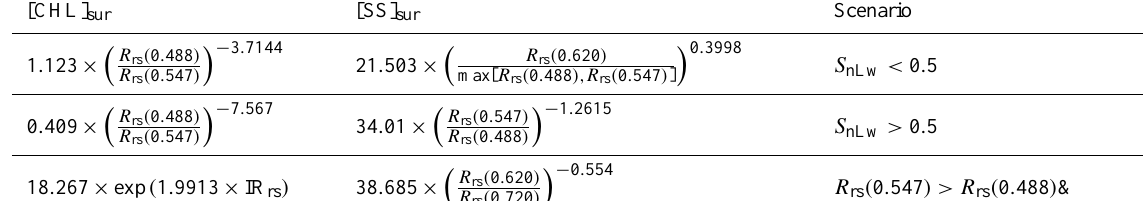
Table 3. Empirical relationships between the in situ R rs and in situ surface concentration ([Chl] sur and [SS] sur ) in a variety of waters for three different scenarios. Note that S.No. 3 will have another expression [Chl] sur = 17.128 × exp(0.888 × IR rs ) if one intends to use R rs (0.680) instead of R rs (0.690) in Eq. (37). The empirical coefficients presented in this table are derived based on our in situ data. [CHL] sur